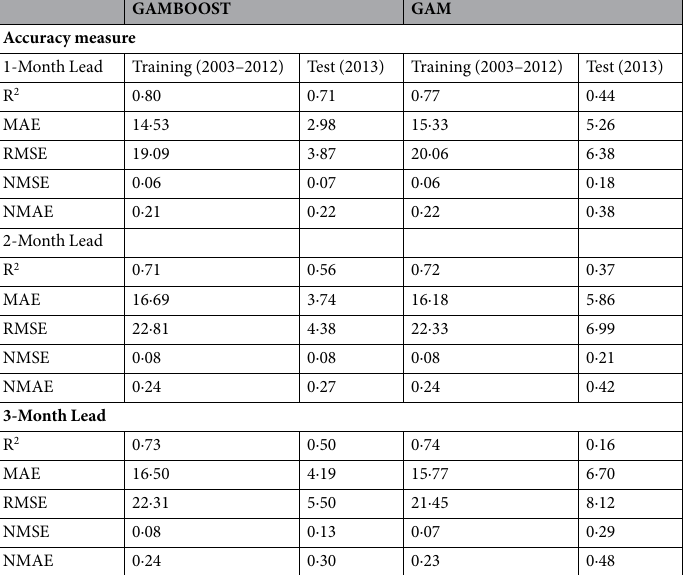
Table 2. Forecast of pediatric malaria admissions at Siaya district hospital, Western Kenya for different prediction lead times by training and test sets including accuracy